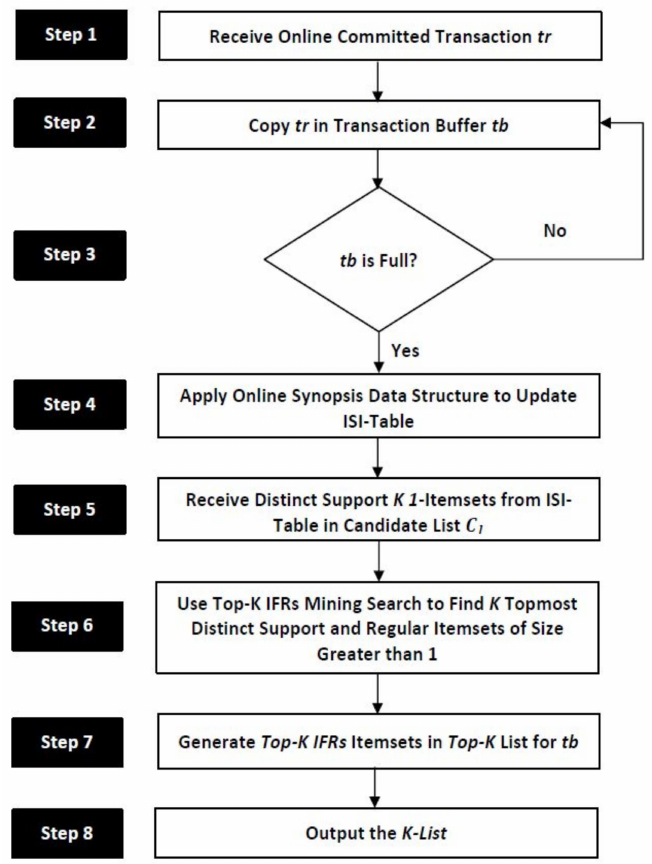
Figure 1. The overall TKIFRPM approach and